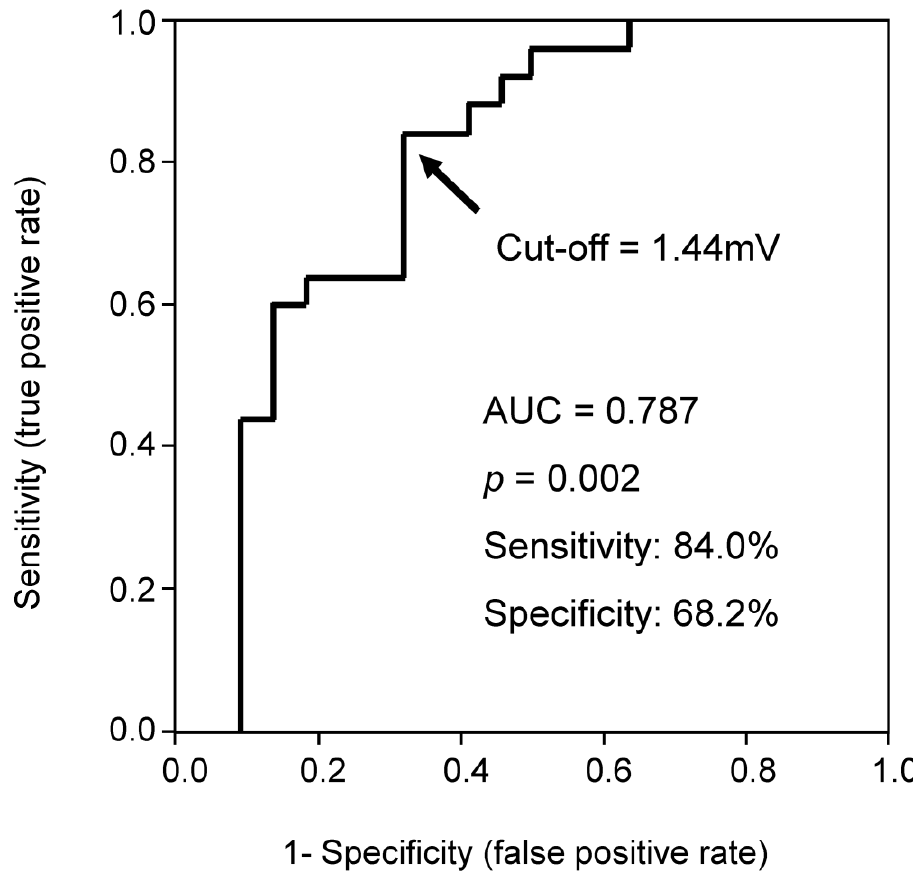
Figure 1. Receiver-operating characteristic curve of averaged S-wave amplitude in right precordial leads for predicting CRT (cardiac resynchronization therapy) responder.